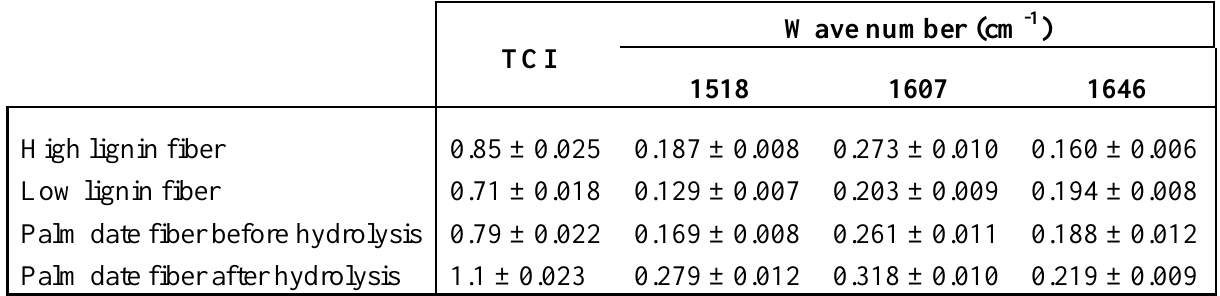
Table 3. Absorption results of FTIR spectra of high lignin and low lignin fibers, palm date fibers before and after hydrolysis.